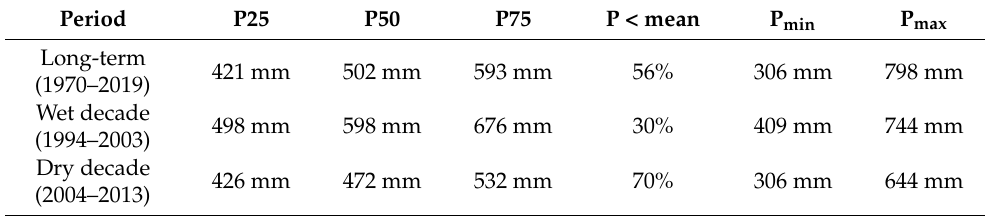
Table A2. Additional indicators of the differences in precipitation between the two periods. P25, P50, and P75 stand for the 25%, 50%, and 75% percentiles, respectively; P < mean, percentage of years with precipitation below the long-term mean (520 mm); P min and P max , minimum and maximum